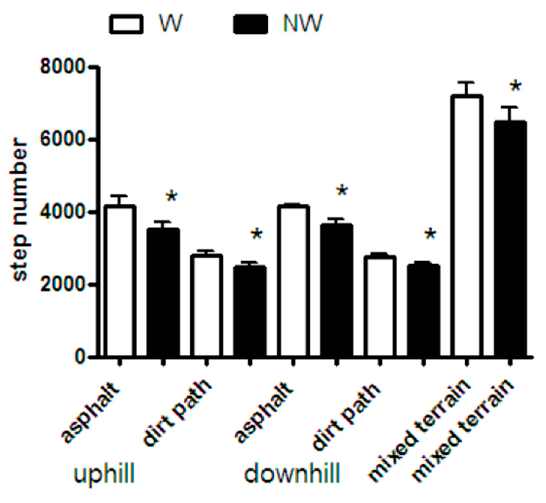
Figure 4. Average numbers of steps in the three tests are plotted for NW and W. The difference in step number implies a difference in stride length, which was calculated to be on average 0.92 ± 0.05 m in NW compared to 0.80 ± 0.04 m in W, using data of all subjects in the three tests ( p < 0.001). In detail, average stride length on asphalt road (second test) was 0.82 ± 0.05 m in W and 0.97 ± 0.05 m in NW walking uphill and 0.82 ± 0.03 m in W and 0.93 ± 0.04 m in NW walking dowhill; on dirt path (third test) stride length was 0.79 ± 0.03 m in W and 0.88 ± 0.03 m in NW uphill and 0.77 ± 0.03 m in W and 0.88 ± 0.03 m in NW downhill.